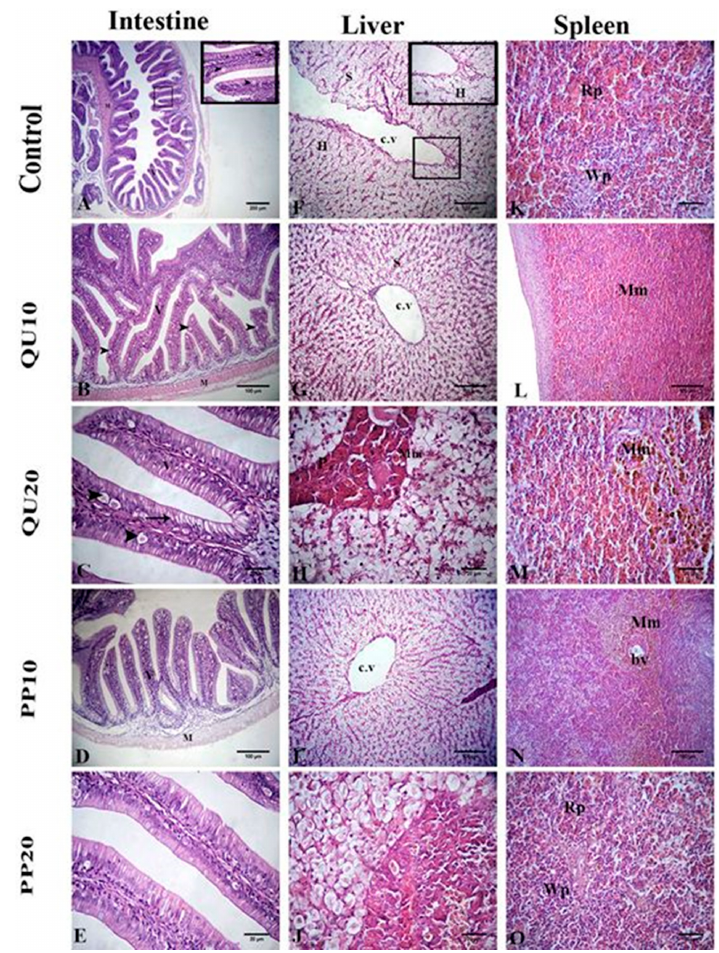
Figure 5. Representative photomicrographs of H&E-stained intestinal tissue sections of Nile tilapia ( A – E ): control group ( A ), QU 10 - ( B ), QU 20 - ( C ), PP 10 - ( D ), and PP 20 - ( E ) supplemented fish showing a normal intestinal wall, including columnar epithelium lining with the villi (thin arrow), large vacuoles (arrowheads), and thin propria submucosa (thick arrow) (villi (V) and musculosa (M)). Representative photomicrographs of H&E-stained liver-tissue sections of Nile tilapia ( F – J ): control group ( F ), QU 10 - ( G ), QU 20 - ( H ), PP 10 - ( I ), and PP 20 - ( J ) supplemented fish showing central vein (cv), portal vein (pv), normal hepatocytes (H), melanomacrophages (Mm), sinusoids (s), and pancreatic acini (p). Representative photomicrographs of H&E-stained spleen-tissue sections of Nile tilapia ( K – O ): control group ( K ), QU 10 - ( L ), QU 20 - ( M ), PP 10 - ( N ), and PP 20 - ( O ) supplemented fish showing a normal histological structure with red (Rp) and white pulps (Wp), along with melanomacrophage centers (Mm) around the blood vessel (bv).